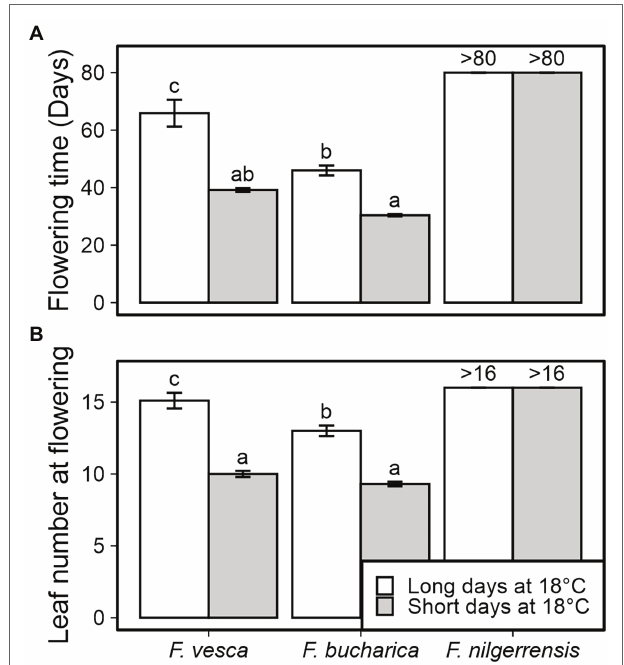
FIGURE 2 | Flowering time in three diploid strawberry species grown in SDs or LDs at 18 ° C. Number of days (A) and number of leaves developed (B) until the first flower opened. Stolon-propagated plants were grown in LDs (18-h) or SDs (12-h) at 18 ° C for 6 weeks followed by LDs (18-h) at 18 ° C. Flowering time was recorded every other day and leaf number was scored at flowering time. Error bars represent the SEM ( n = 10), and different letters indicate significant differences calculated by ANOVA and Tukey’s test ( p < 0.05). For plants that remained vegetative, the number of days recorded (>80) or the number of leaves observed (>16) is